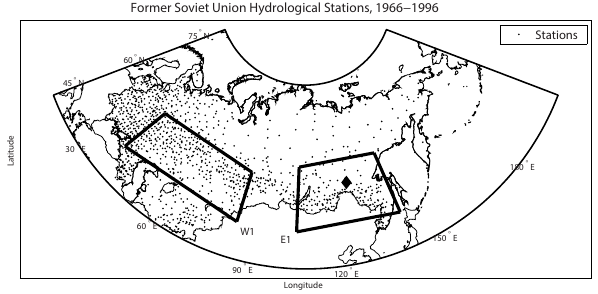
Fig. 1. Location of hydrological stations considered in this study; note the scarcity over northern Siberia. The limits of the western (W1) and eastern (E1) geographical subsets used in Sect. 4.4 are indicated by the rectangles. The diamond marker in E1 indicates the position of the Mogot Basin (55.5 ◦ N, 124.7 ◦